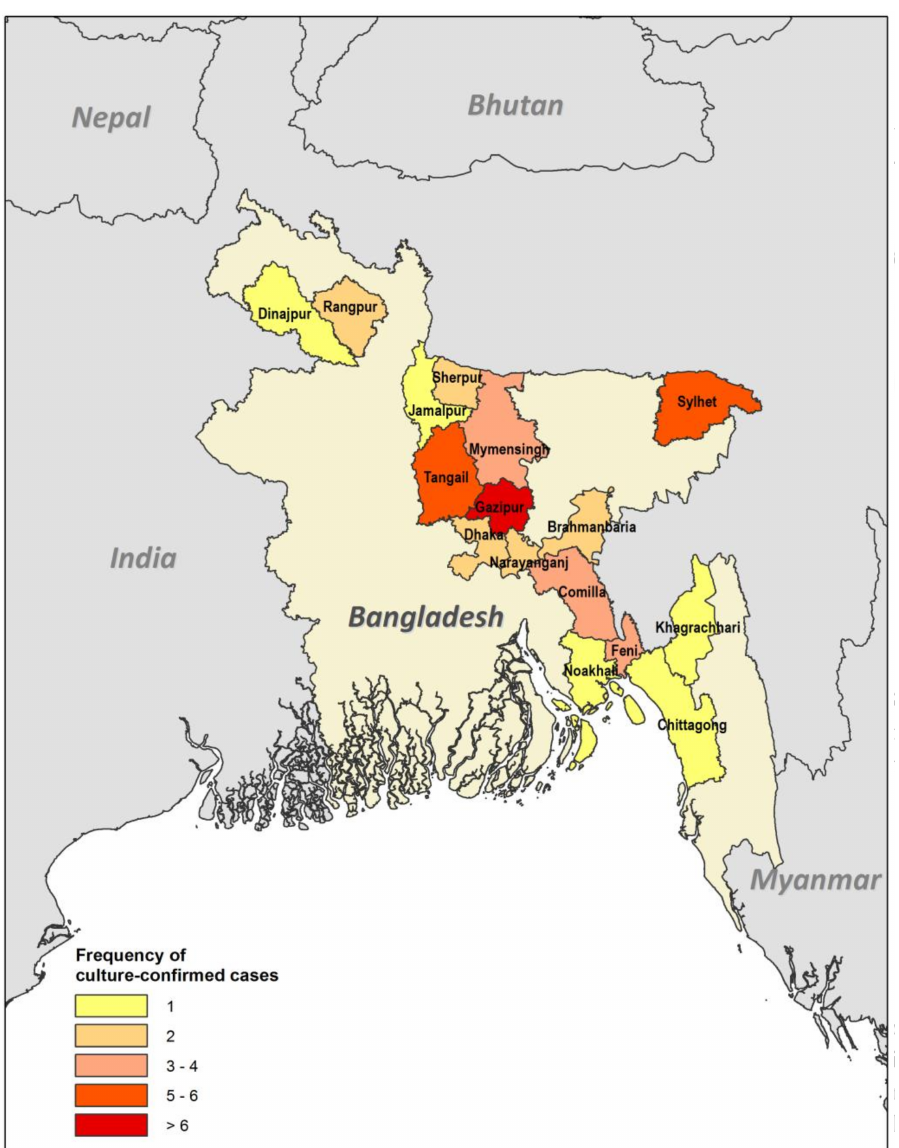
Figure 1. ChoroplethmapbasedonGISdata. Themapillustratesthefrequencybydistrictofculture-confirmed cases of melioidosis ( n =